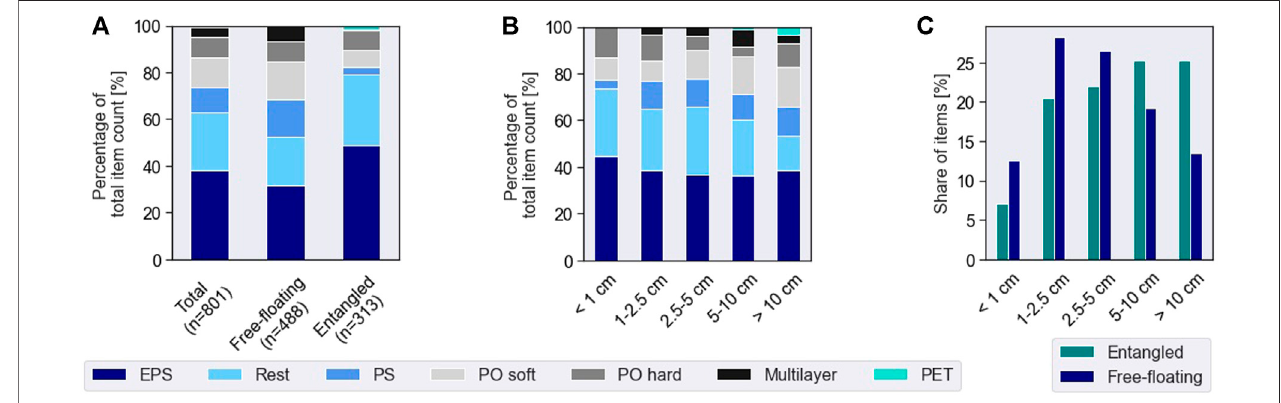
FIGURE 4 | Plastic composition of observed items (A) , in relation to size categories (B) and overall size distribution (C)